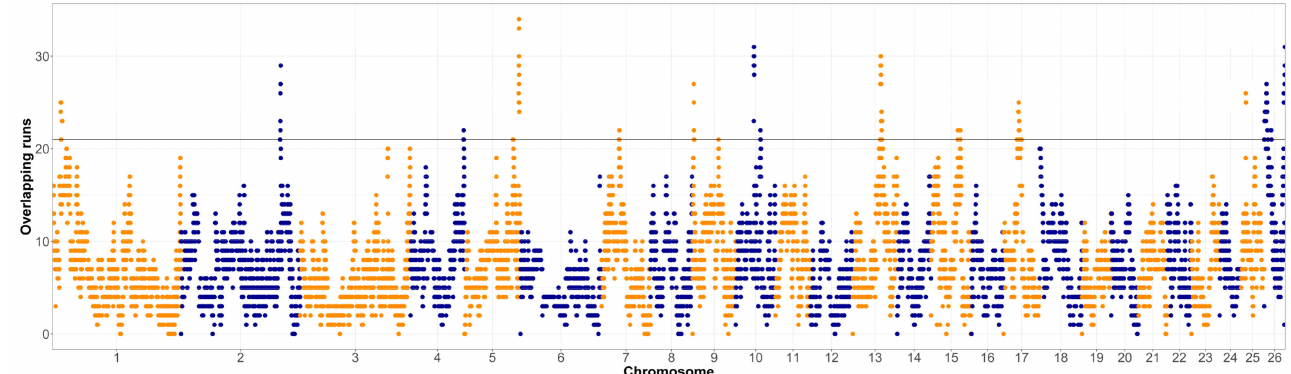
Figure 1. Runs of homozygosity islands in the Original Valachian sheep population (horizontal line denotes the top 1% of most homozygous regions, alternating colors distinguish markers on neighboring chromosomes).